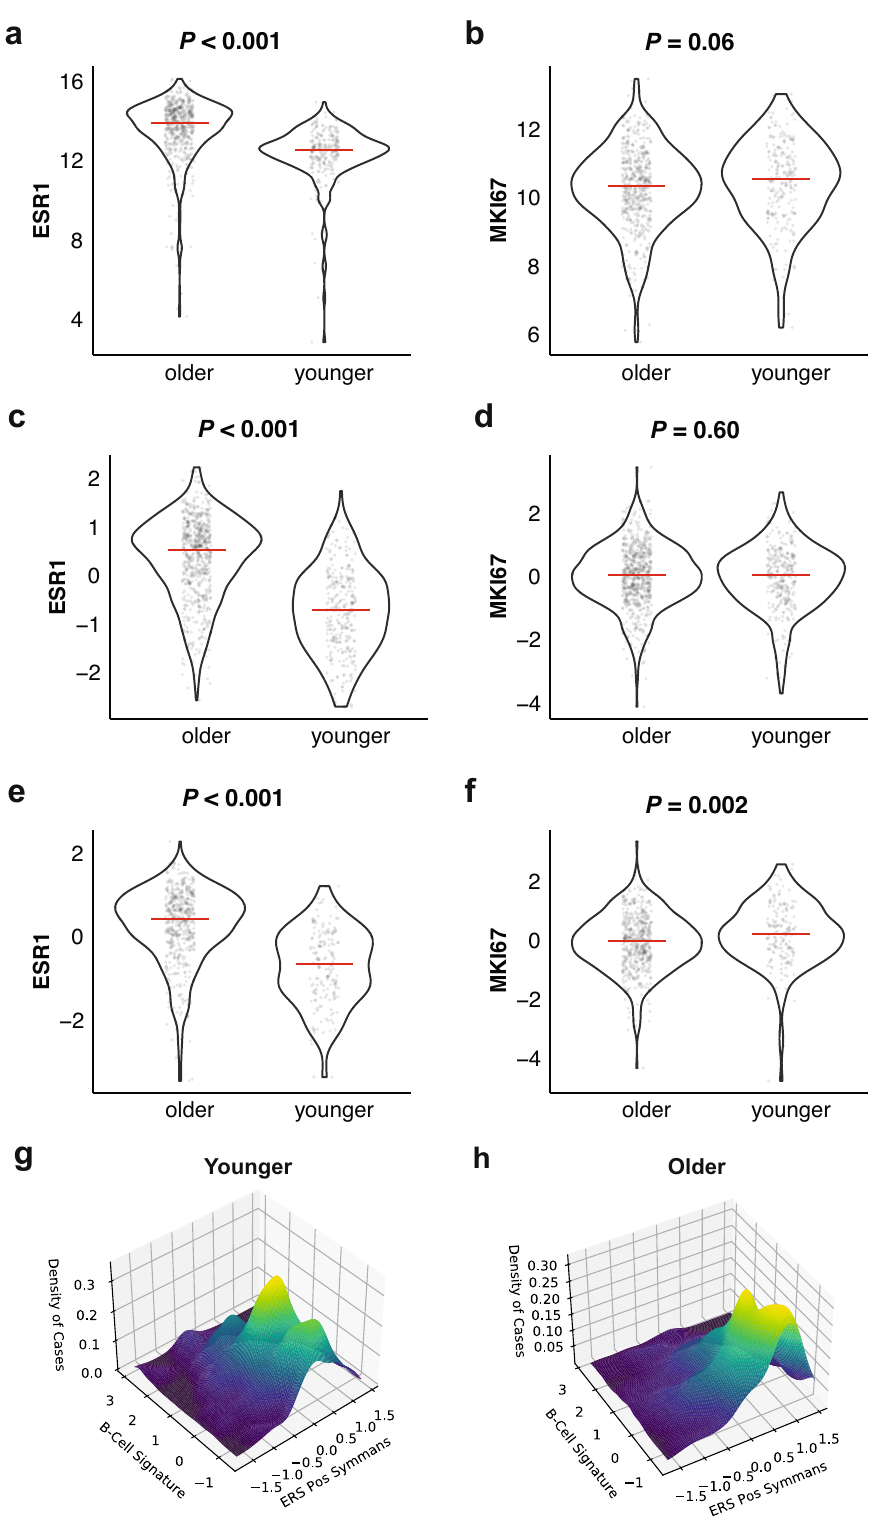
Fig. 1 Expression of estrogen receptor ( ESR1 ) and proliferation marker ( MKI67 ) in older and younger ER + /HER2 − breast cancer patients. a ESR1 mRNA and b MKI67 mRNA expression in TCGA cohort; c ESR1 and d MKI67 expression in Microarray Cohort-A; e ESR1 and f MKI67 expression in Microarray Cohort-B. P-values were estimated by the two-side Wilcoxon rank-sum test. Each dot represents a patient, the solid horizontal line indicates the median expression in each age group. Relationship between ERS-pos and B-Cell gene signatures in women 50 years of age or younger ( g ) and 55 years of age or older ( h ). The values from negative to positive in the X and Y axes denote increasing signature expression. Z -axis indicates case density (i.e., number of patients), color coding re fl ects increasing case density from dark blue to